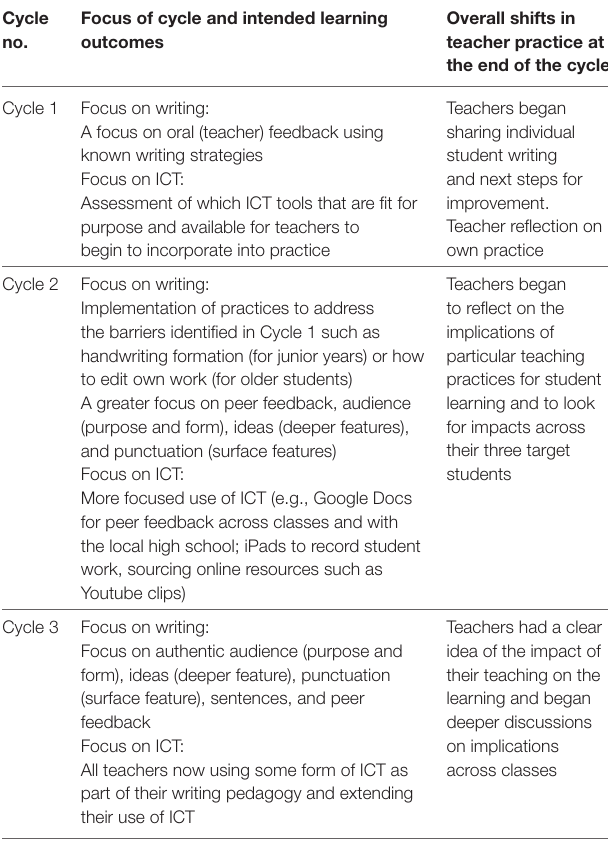
TaBle 1 | The three cycles of teacher collaborative